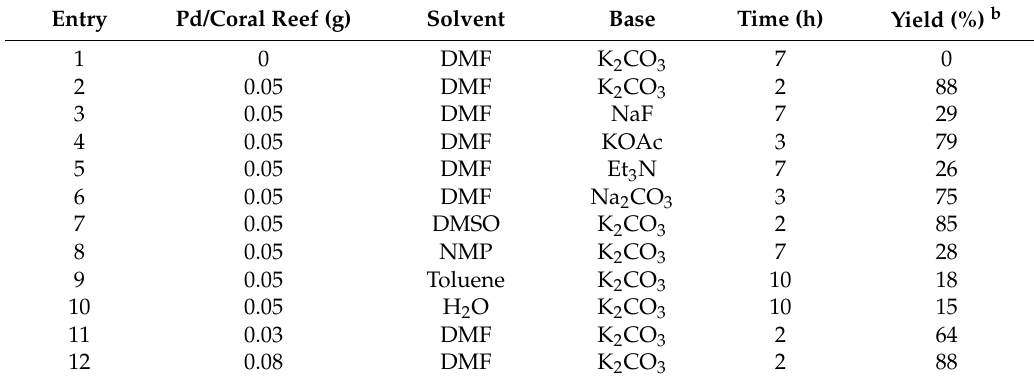
Table 1. Pd/coral reef-catalyzed cyanation of iodobenzene using K 4 Fe(CN) 6 at 120 ◦ C under different conditions a .